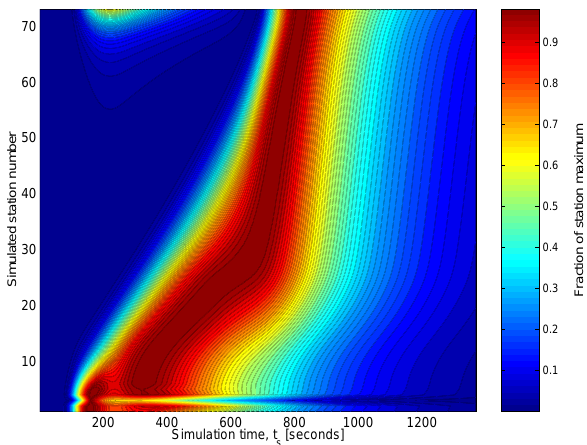
Fig. 8. A formedogram of the model T i response (see Fig. 7), nor- malized to the local maximum for each simulated